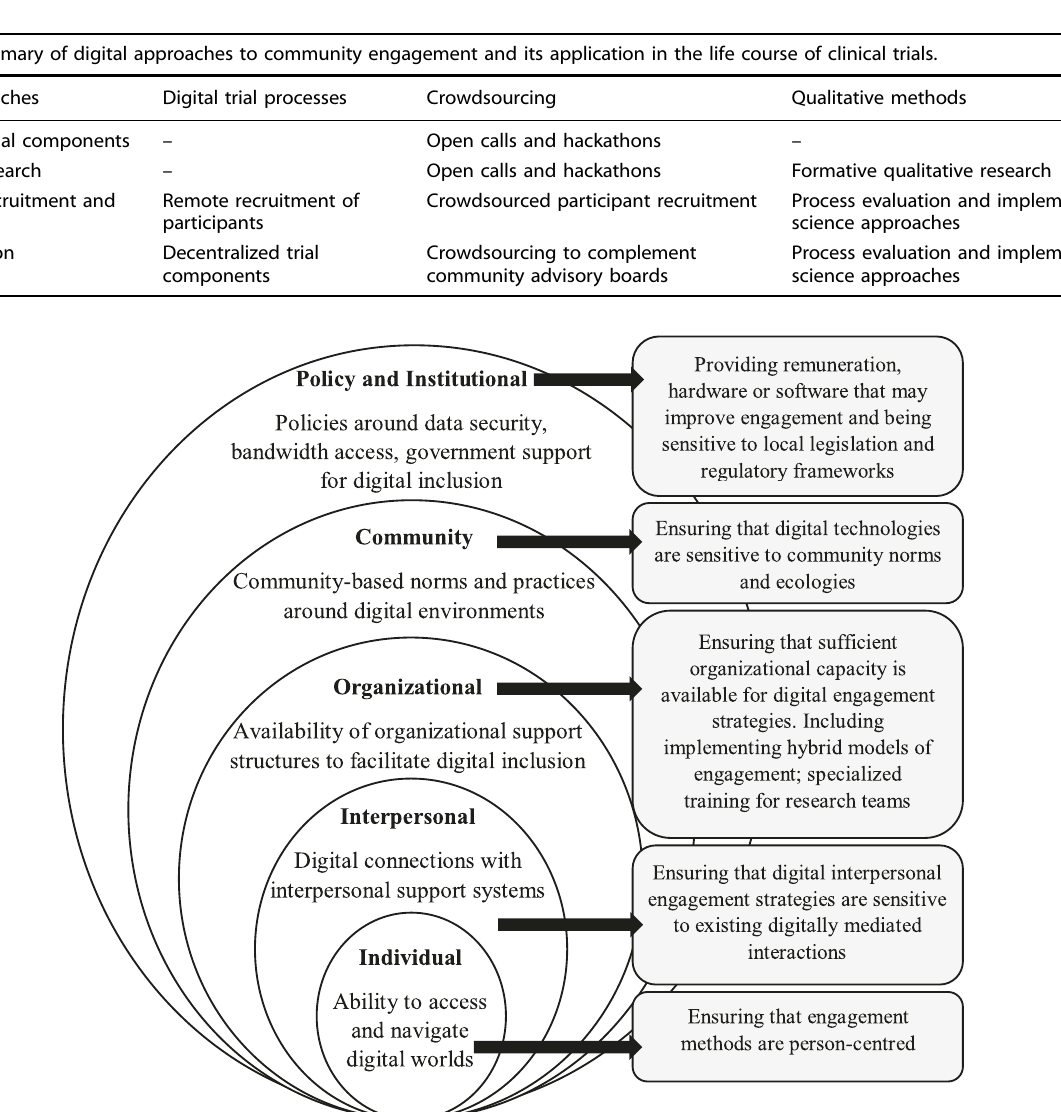
Fig. 1 Revised socio-ecological model and recommendations for digital inclusion. Revised socio-ecological model providing considerations and potential solutions for digital inclusion at the individual, interpersonal, organizational, community, and policy